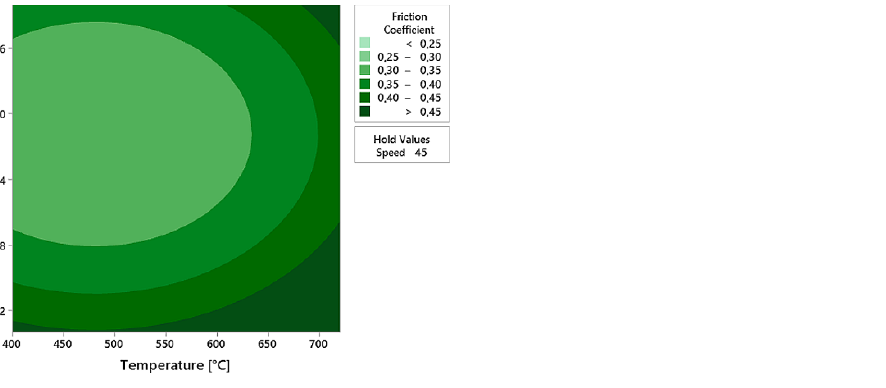
Figure 4. Contour Plot of Friction Coefficient vs. Temperature and Pressure for a Hold Value of Speed of 45 mm/s.